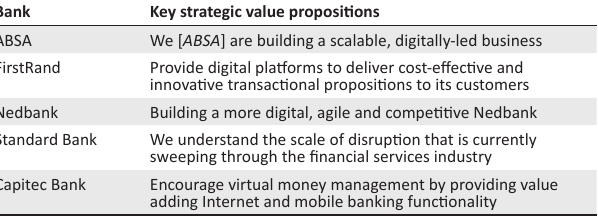
TABLE 2: Selected strategic value propositions relating to Fintech by the South African retail banks.